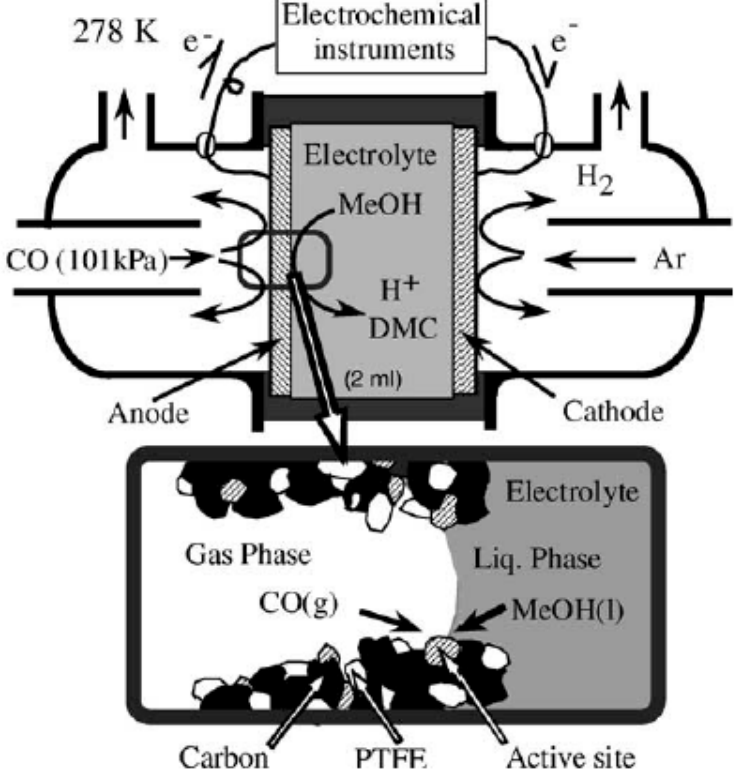
Figure 3. Schematic diagram of three-phase-boundary electrolysis for DMC synthesis [33].